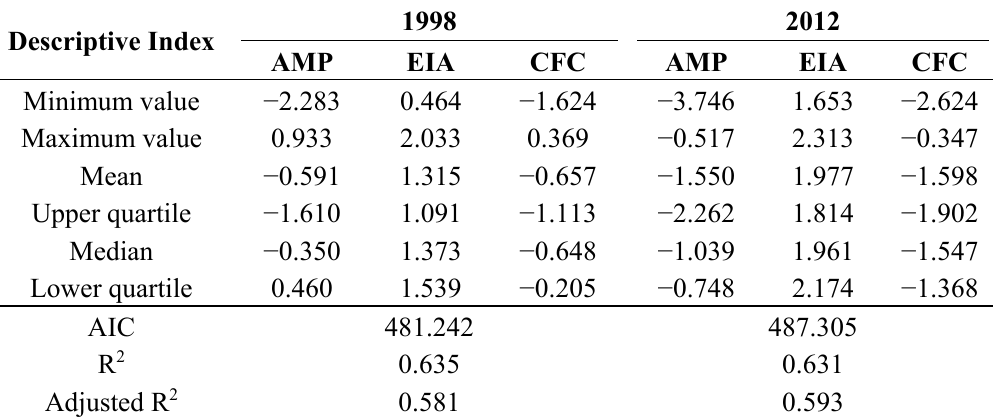
Table 3. Statistical description of the geographically weighted regression (GWR) model parameter for 1998 and 2012.